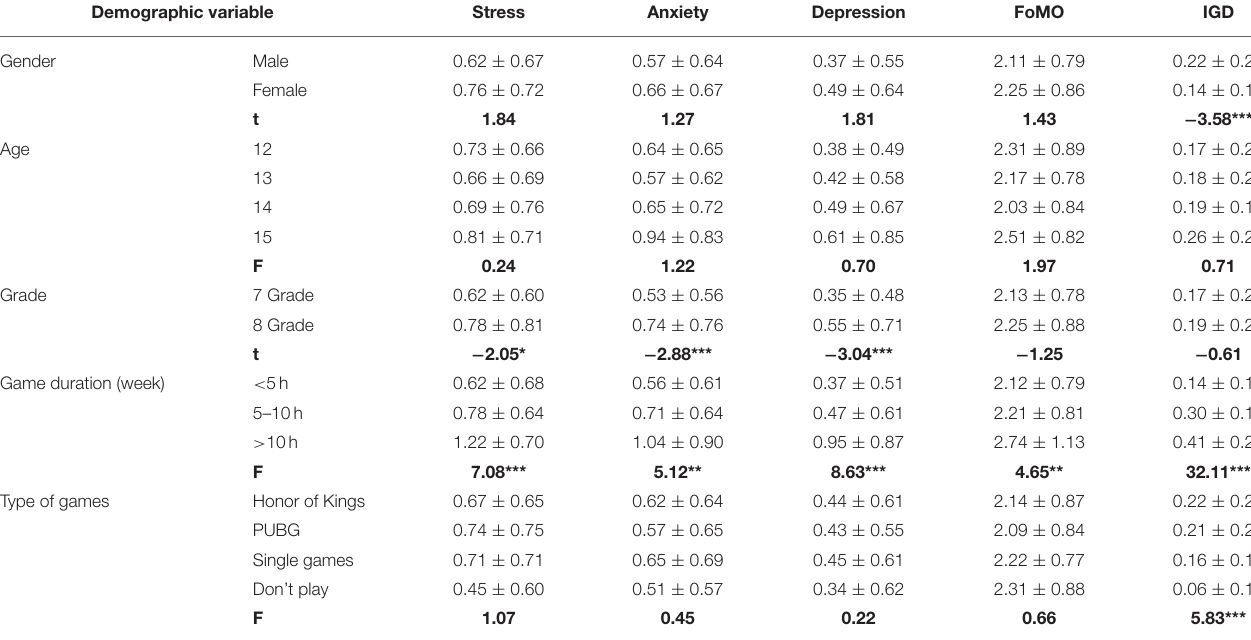
TABLE 1 | Descriptive statistics (M ± SD) and Difference tests of each variable.